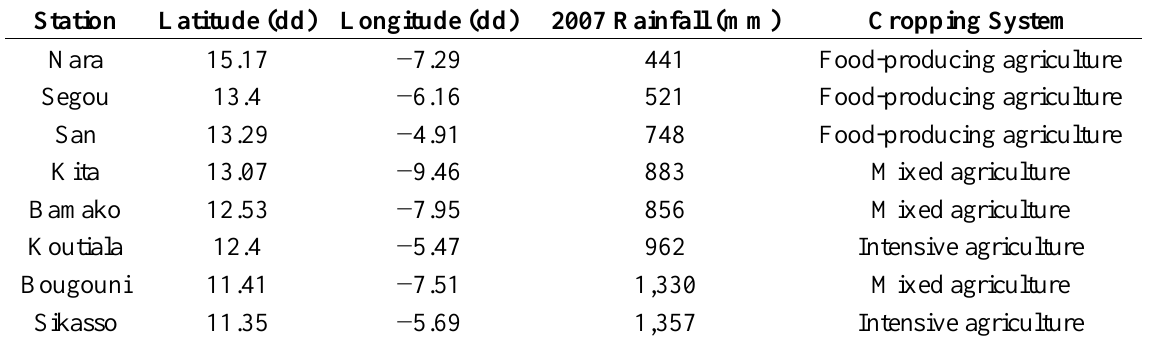
Table 1. Synoptic station characteristics from north to south.